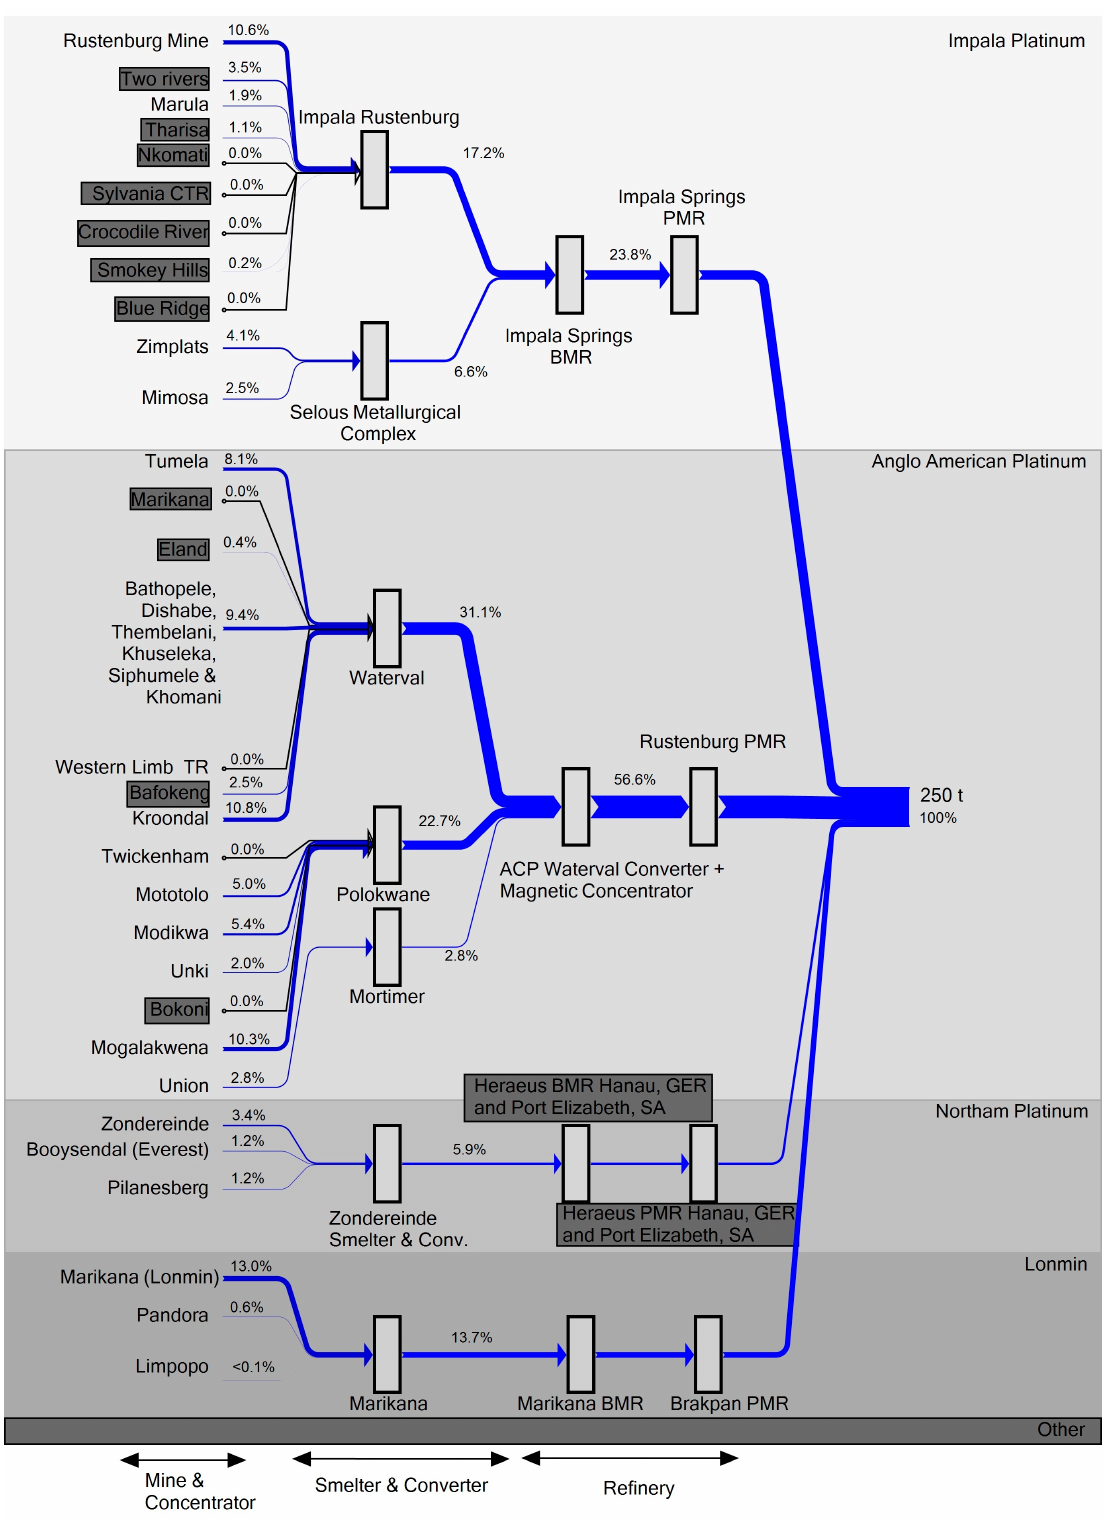
Figure 1. Industry structure and share of production in 2015. Companies possessing the largest share of an entity are considered as the operator/owner. Data from part I [1].